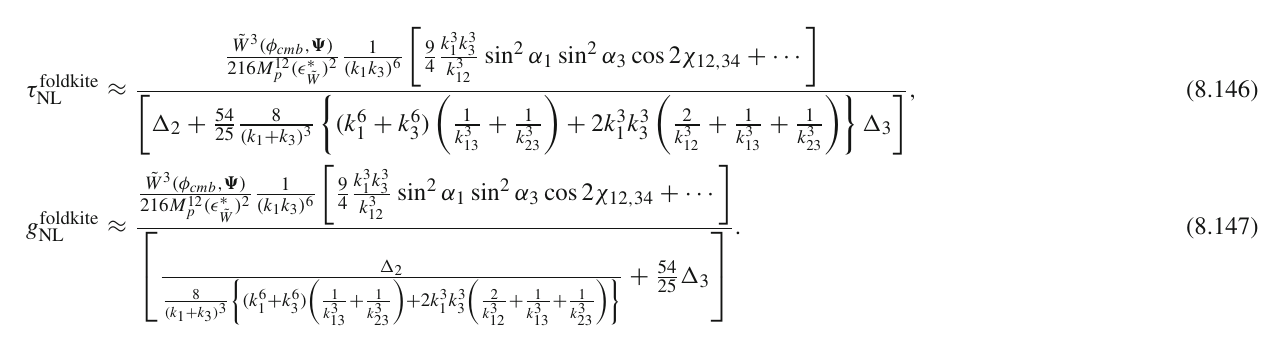
Figs. 19a, b, 23a, b for two different angular orientations: Angle I and Angle II. From the representative surfaces it is clearly observed the behavior of scalar four point non- Gaussian amplitude in the folded kite limit for the variation ¯ λ of two fold parameter α and and the results are consis- tent with the obtained constraints in 2D analysis. Here all the obtained results are consistent with the two point and three point constraints as well as with the Planck 2015 data [44–46].